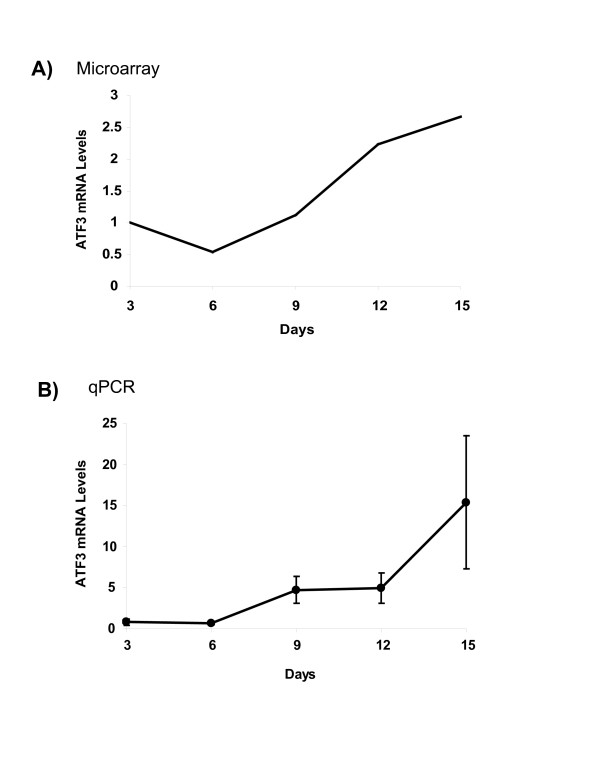
Atf3 expression is upregulated during chondrocyte differentiation in vitro. Atf3 mRNA expression during chondrogenic differentiation of mouse embryonic limb bud cells in micromass culture was examined by microarray (A) and real-time PCR (B) analyses (different cell isolations were used for the experiments in A and B). Microarray data sets represent averages from three independent experiments. Real-time data were normalized to Gapdh levels and present average and SEM from four independent experiments. Both approaches show similar expression patterns with a strong increase in Atf3 expression during micromass differentiation.